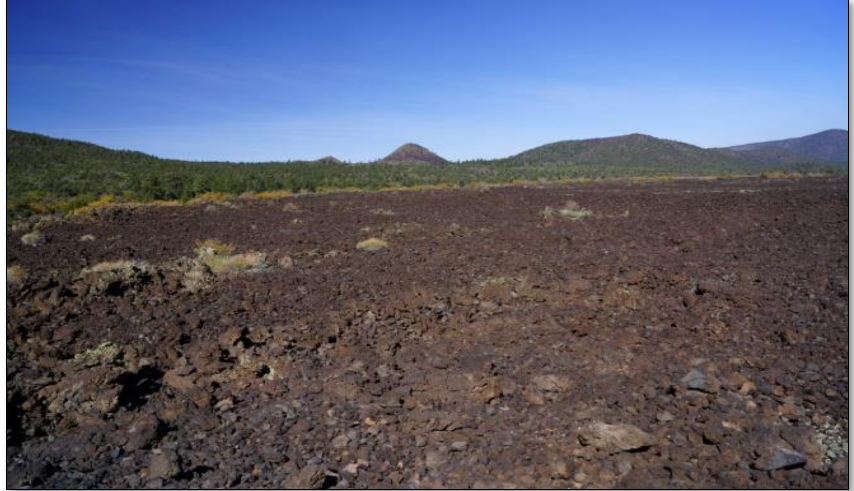
Figure 17. Little Spring Cinder Cone on Horizon Seen from End of the Southern Lobe.